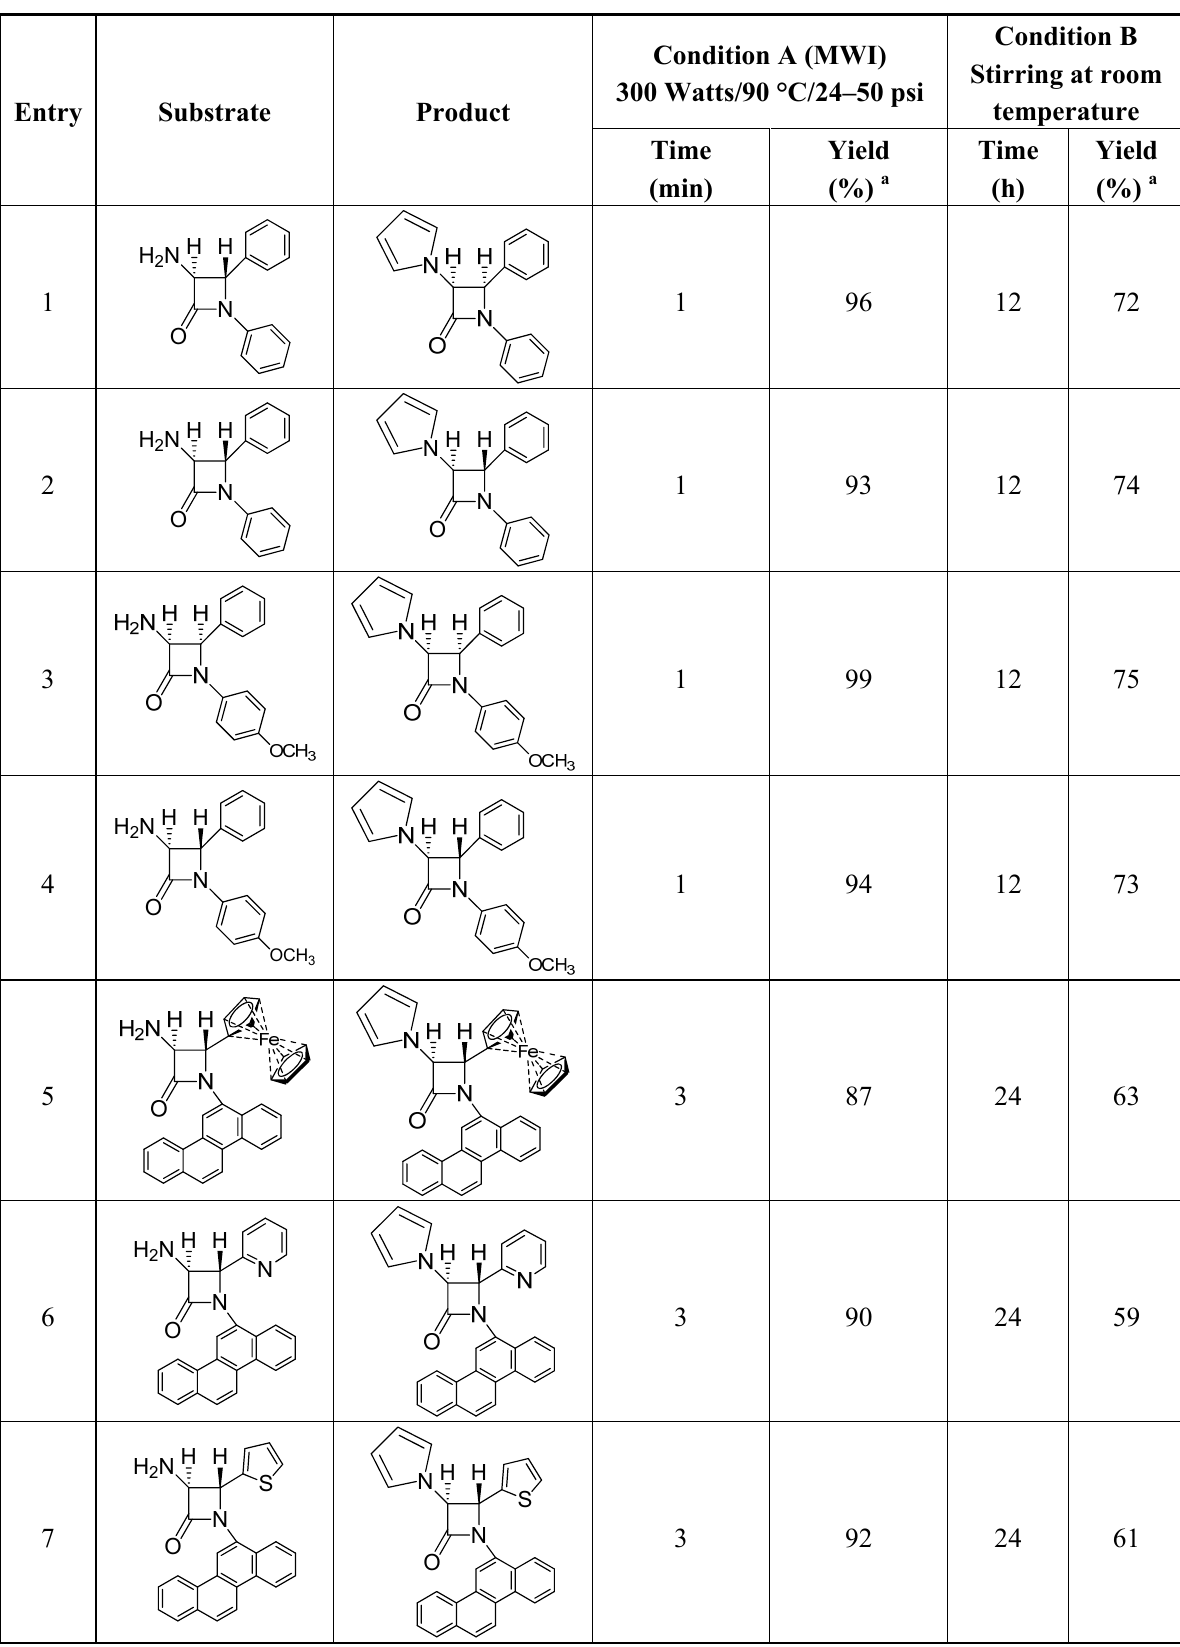
Table 3. Molecular iodine-catalyzed microwave-assisted synthesis of 3-pyrrole substituted 2-azetidinones following Schemes 1 and